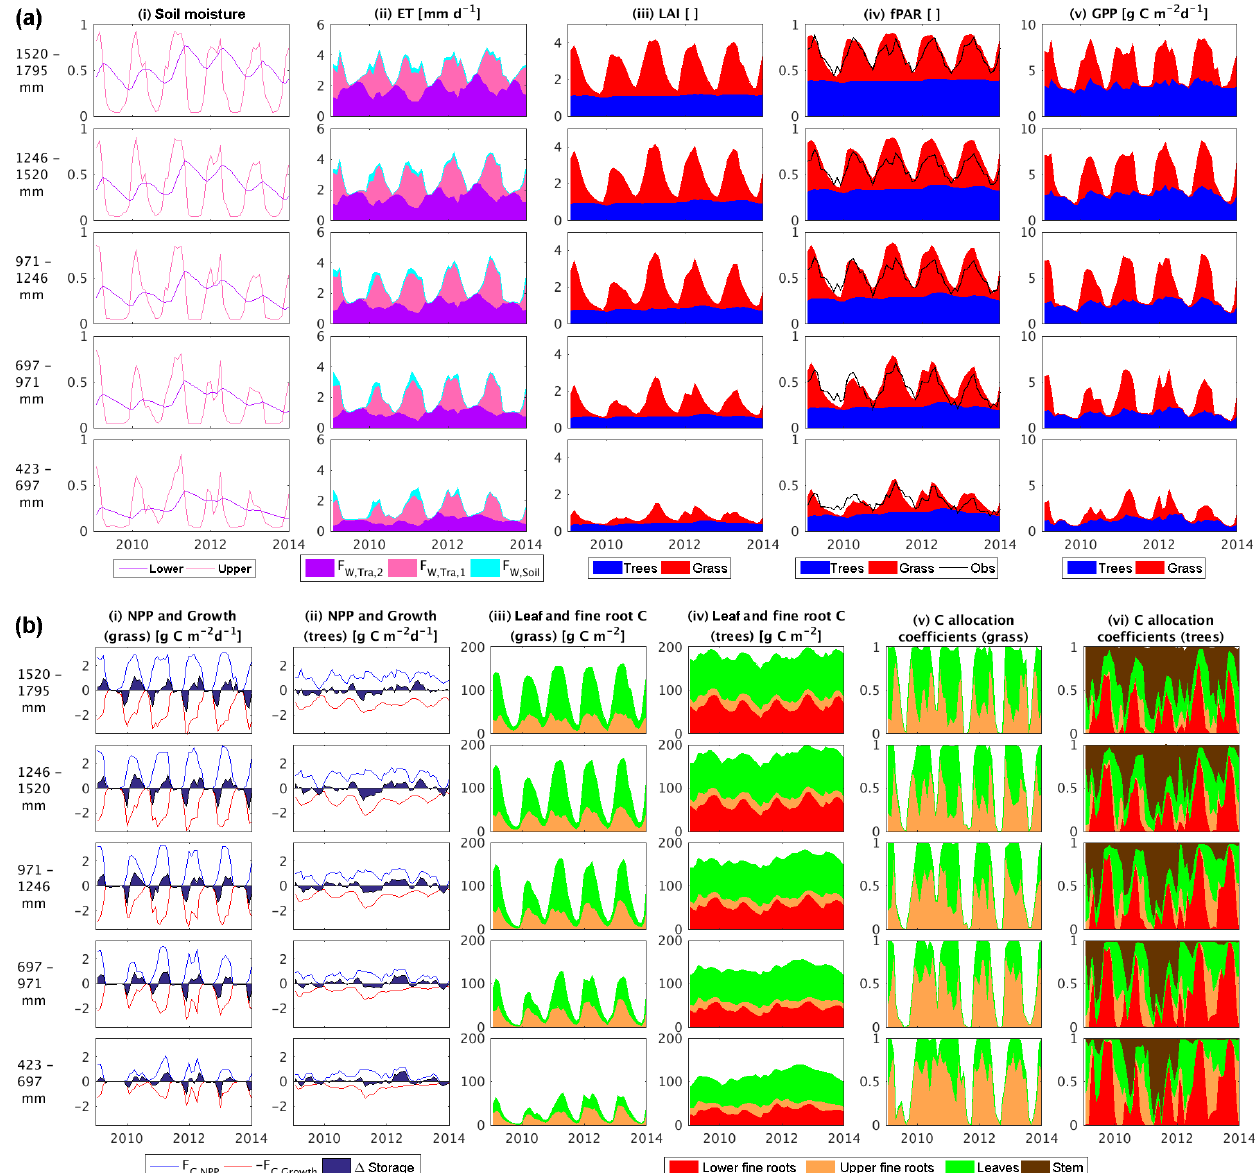
Figure 6. (a) Monthly time series (2009–2014) of (i) soil moisture ( w 1 and w 2 ) , (ii) ET, (iii) leaf area index (LAI), (iv) fPAR, and (v) GPP, as predicted by HAVANA-POP. Corresponding observed fPAR is also shown. Each row represents a spatial average over the randomly sampled grid cells (Fig. 2a) falling within the range of mean annual precipitation shown on the left. (b) Monthly mean time series (2009–2014) of (i) NPP, growth, and change in storage (grass); (ii) NPP, growth, and change in storage (trees); (iii) leaf and fine root carbon pools (grass); (iv) leaf and fine root carbon pools (trees); (v) C allocation coefficients to leaves and fine roots (grass); and (vi) C allocation coefficients to leaves, fine roots, and stems (trees). Spatial aggregation is the same as in Fig.